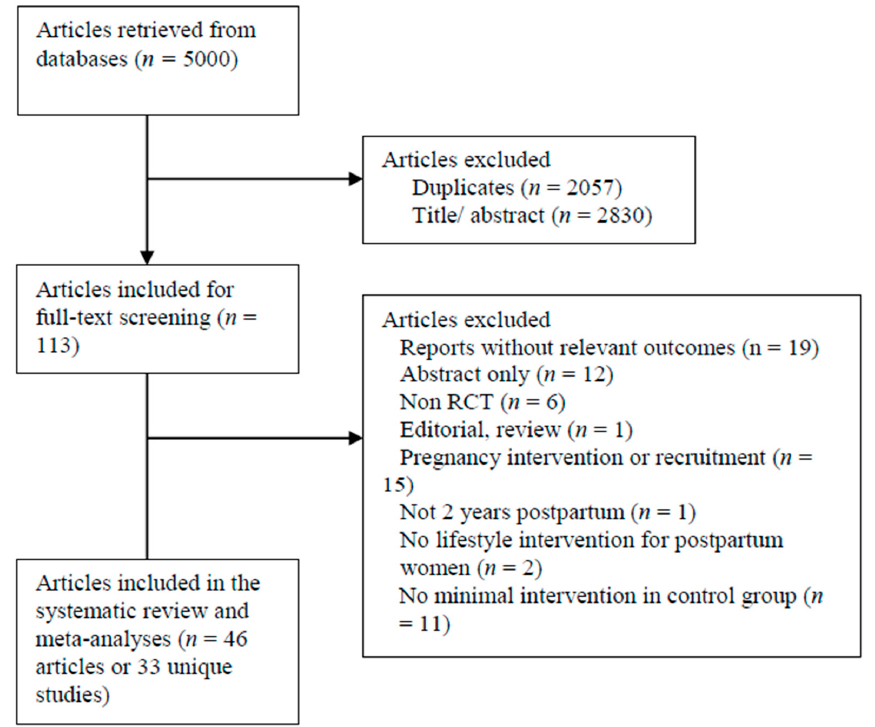
Figure 2. Preferred Reporting Items for Systematic Reviews and Meta-Analyses (PRISMA) procedural flow chart of search and identification process.